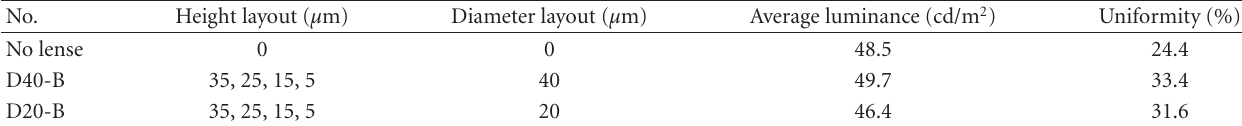
Table 3: The parameter layouts of gray microlens array optical films.